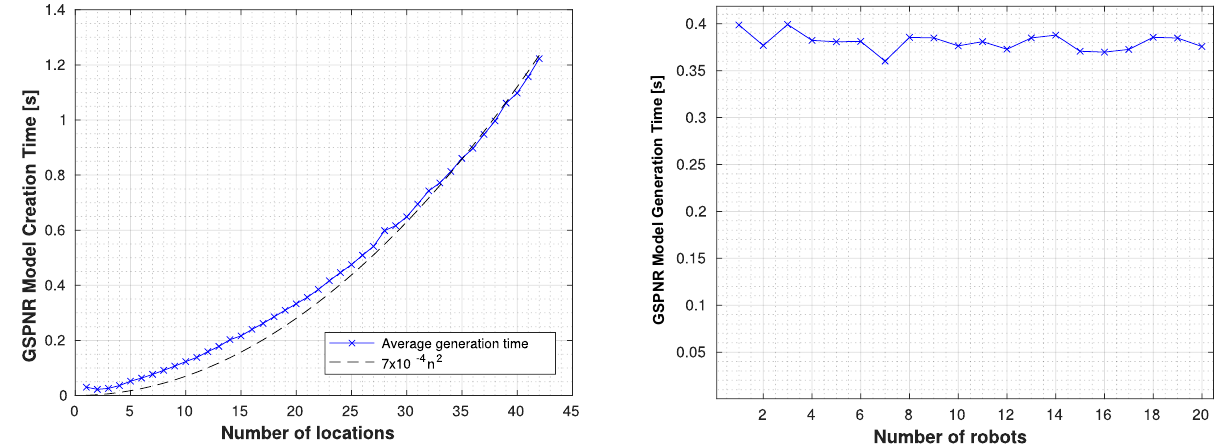
Figure 8. ( Left ) Time required to generate the GSPNR model as the number of locations grows, where n represents the number of locations; ( Right ) Time required to generate the GSPNR model as the number of robots